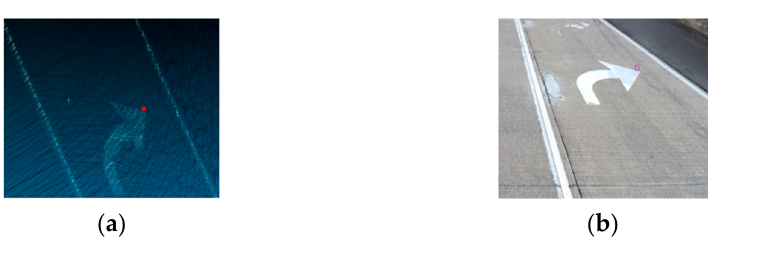
Figure 2. Projection of a location in ( a ) LiDAR point cloud (solid red dot) onto ( b ) corresponding RGB imagery (empty magenta circle) using the estimated LiDAR/camera/GNSS/IMU system calibration parameters.